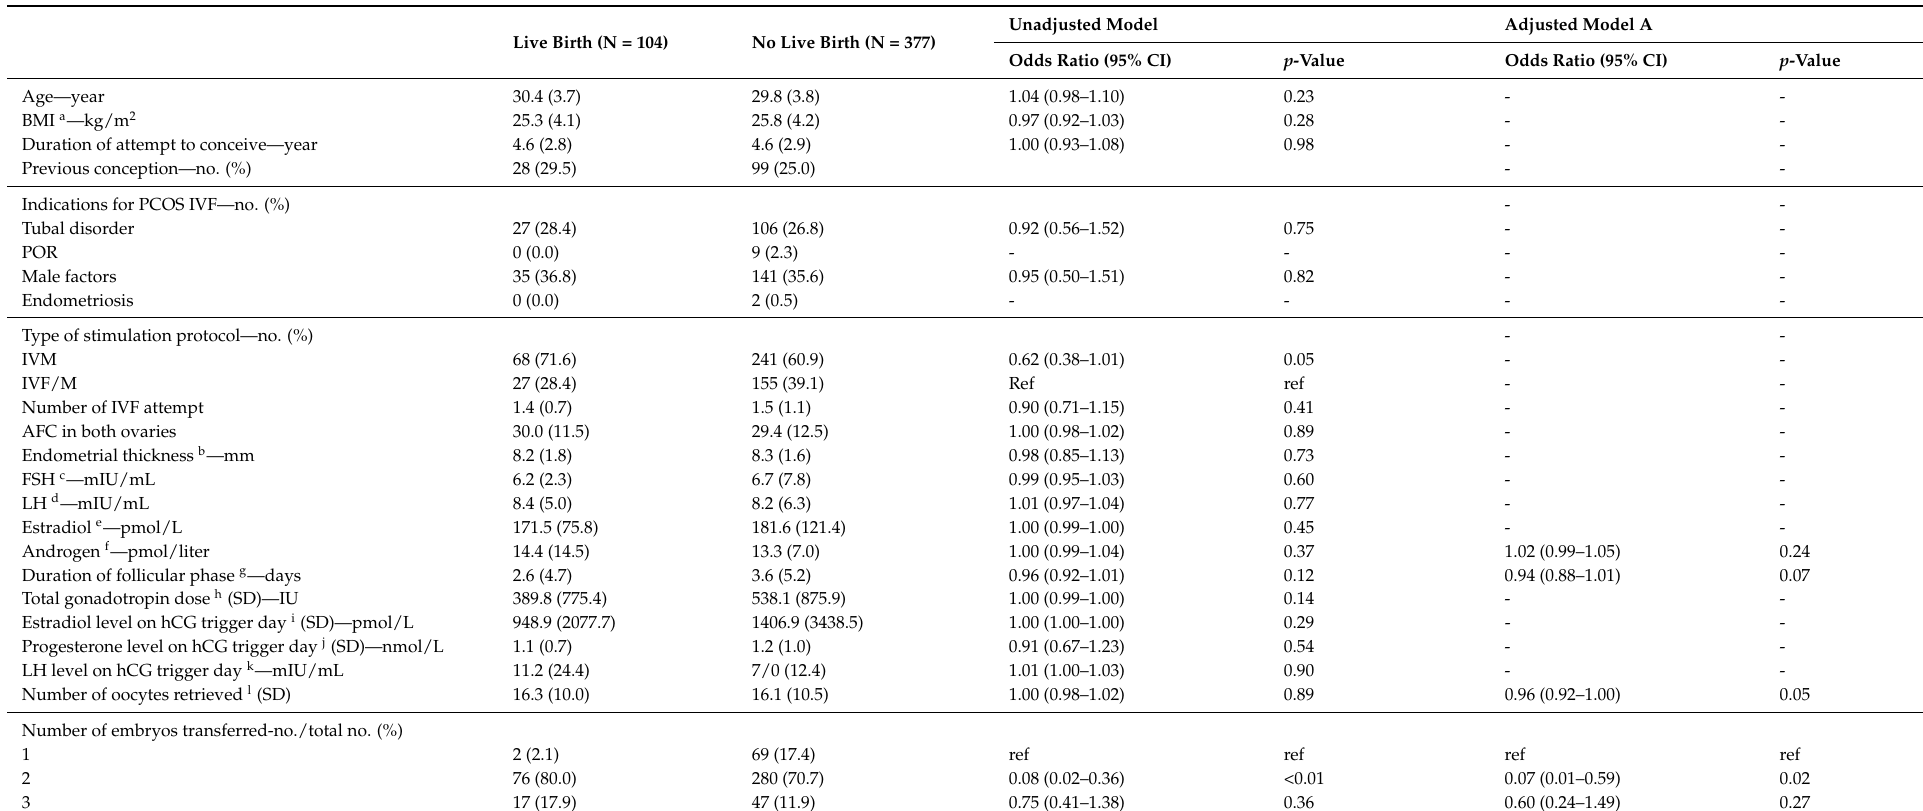
Table 5. Factors associated with the live birth rate after the first embryo transfer of IVM or